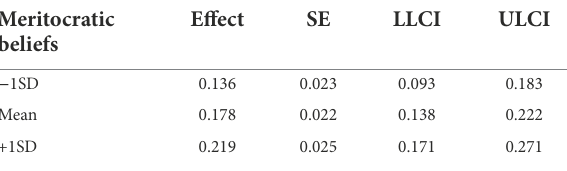
TABLE 5 Bootstrap test results of the moderating mediation